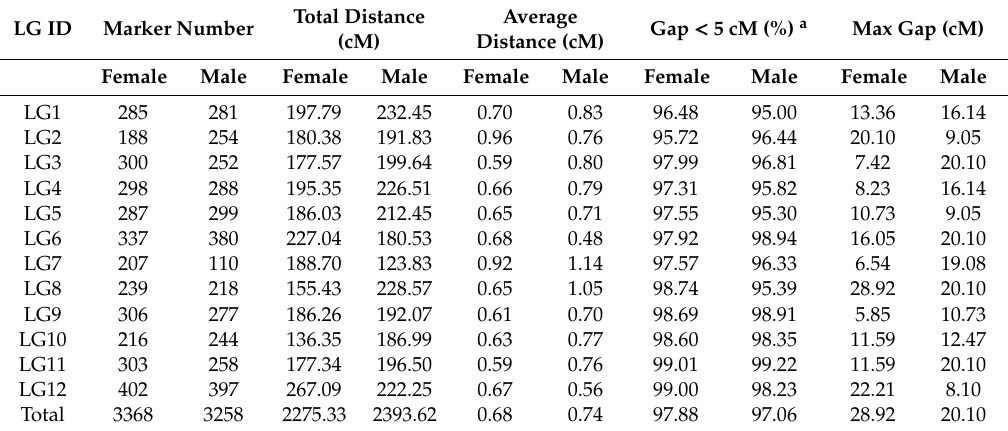
Figure 3. Distribution of SNP markers among the 12 linkage groups of L. principis-rupprechtii . Black line, SNP marker. The linkage group number and genetic distance (cM) are shown on the x - and y -axes, respectively. Table 3. Basic features of the maps for female and male L. principis-rupprechtii